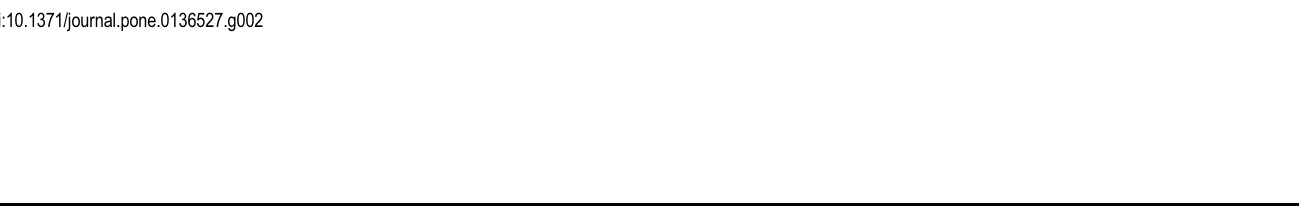
PLOS ONE | DOI:10.1371/journal.pone.0136527 August 26,